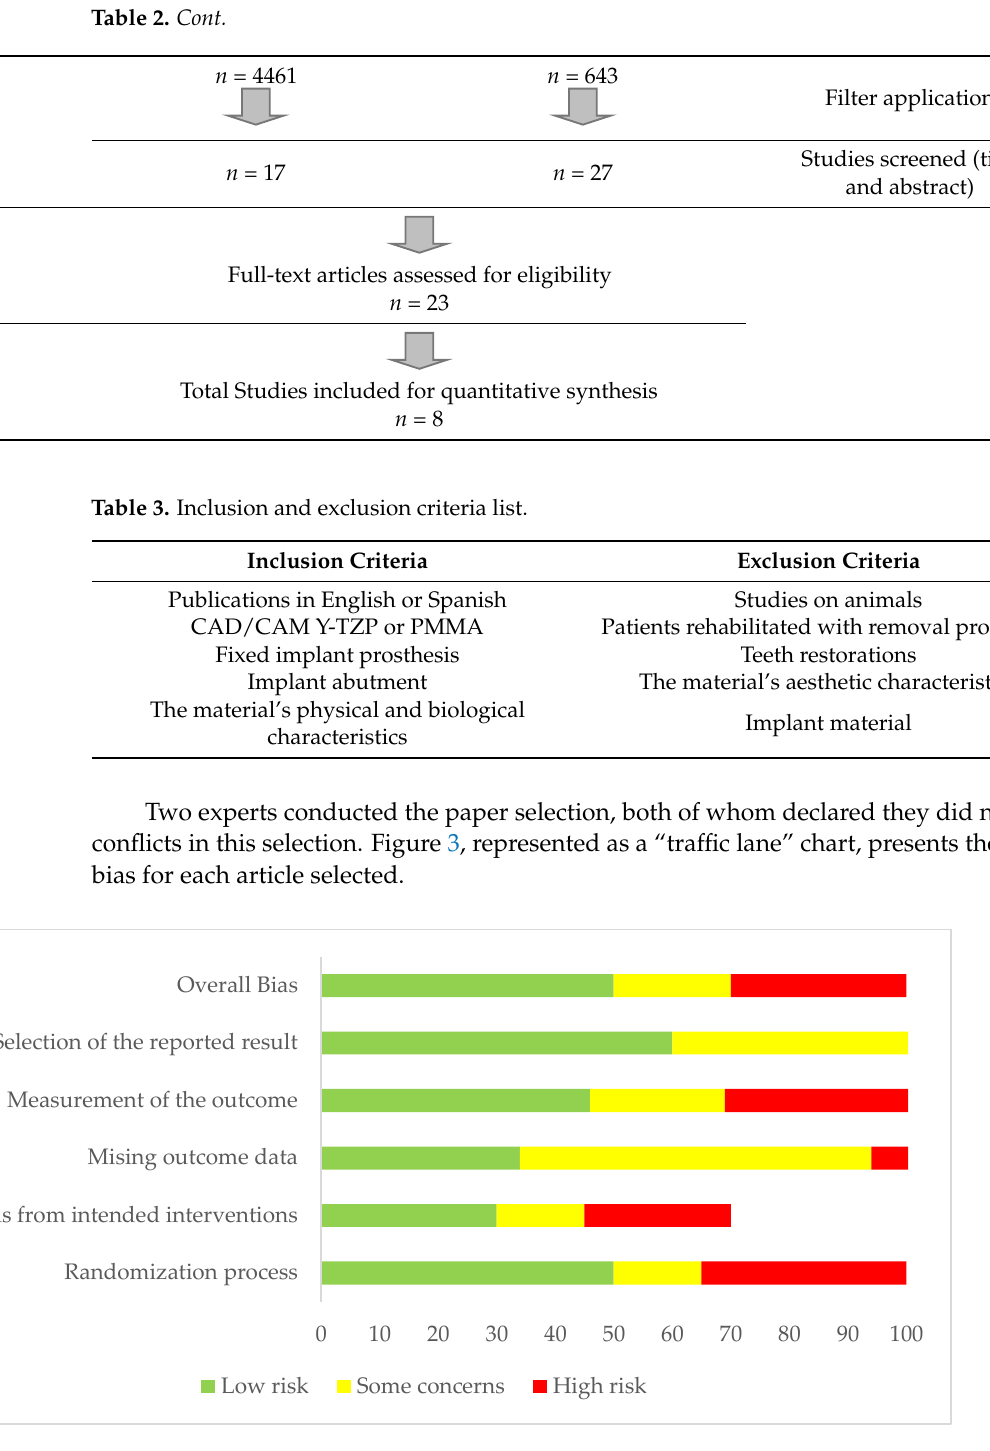
Figure 3. Risk of bias graph, review of authors’ judgements about each risk of bias item presented as a percentage.